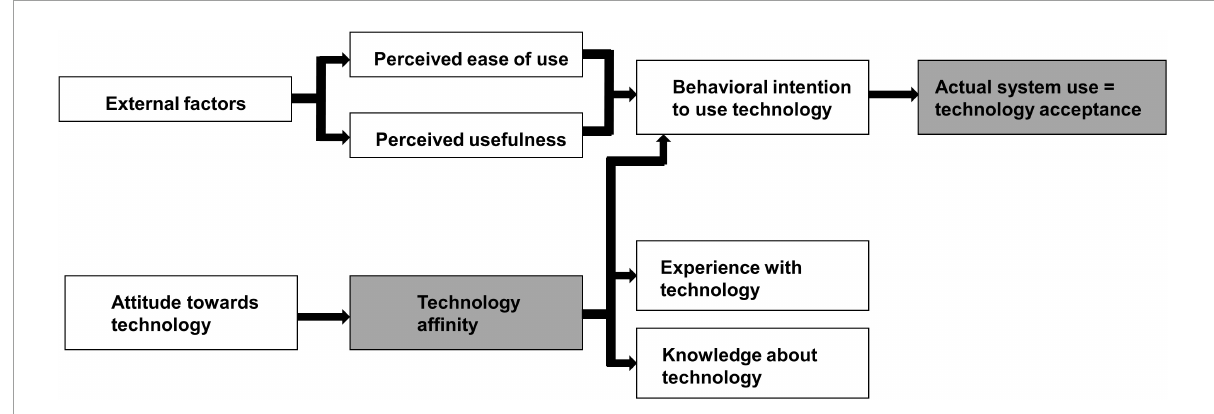
FIGURE1 Relationships between technology affinity and technology acceptance.